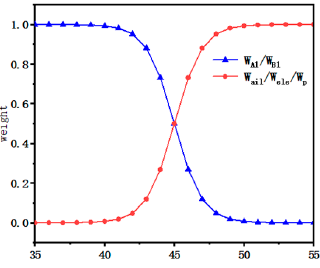
Figure 2. Weight coefficient distribution.